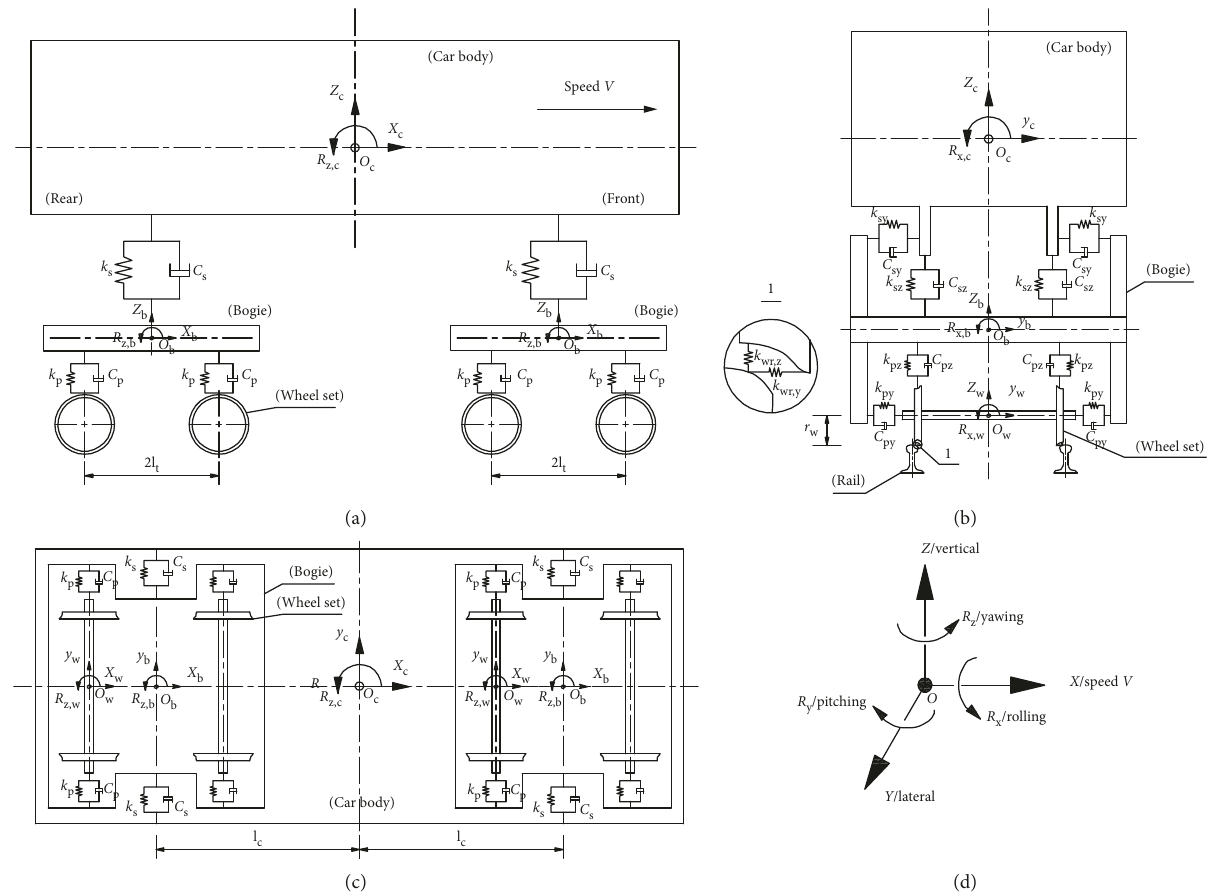
Figure 1: Model, dimensions, and parameters of a vehicle. (a) Side view; (b) front view; (c) top view; (d) sign convention of degree of